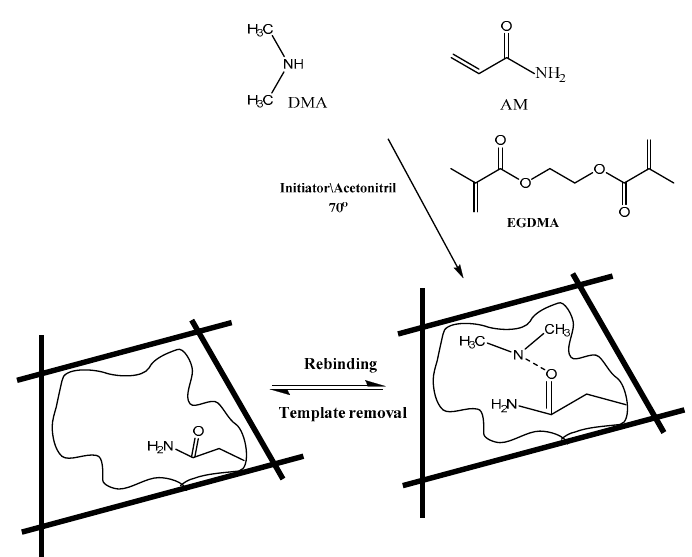
Figure 1. Chemical structure of monomers, cross-linker, and molecularly-imprinted polymers showing non-covalent binding sites to DMA.